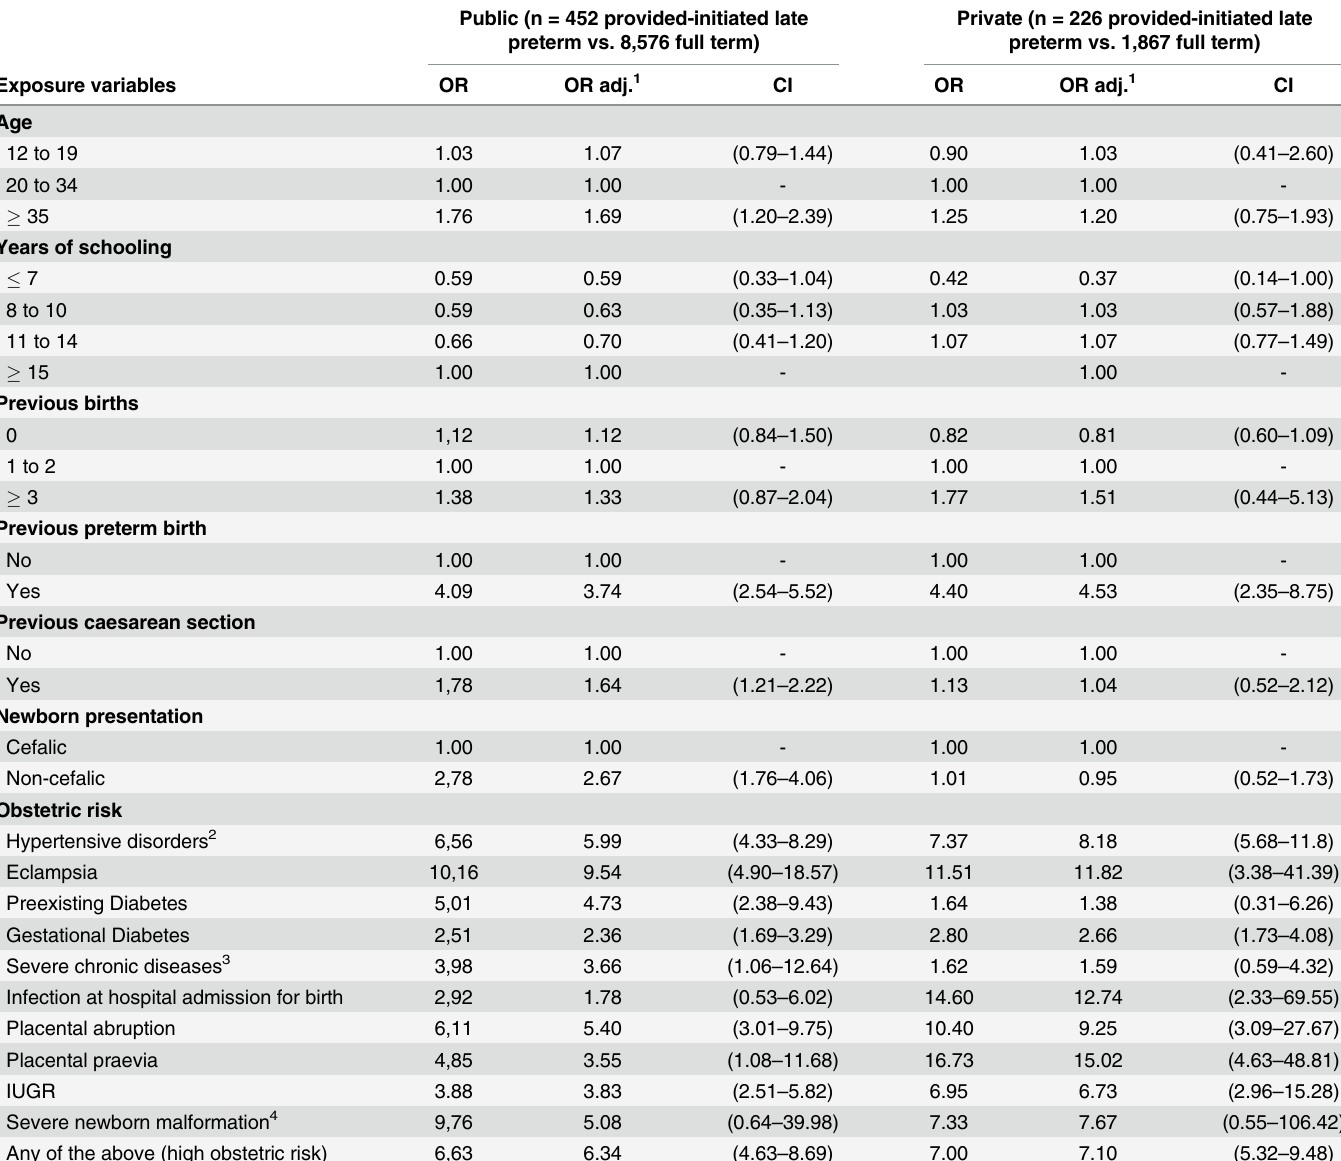
Table 3. Factors associated with provider-initiated late preterm birth (34 – 36 wks) relative to full term birth (39 – 40 wks) by type of childbirth care in singleton live births. Birth in Brazil, 2011 – 2012. Public (n = 452 provided-initiated late Private (n = 226 provided-initiated late preterm vs. 8,576 full term) preterm vs. 1,867 full